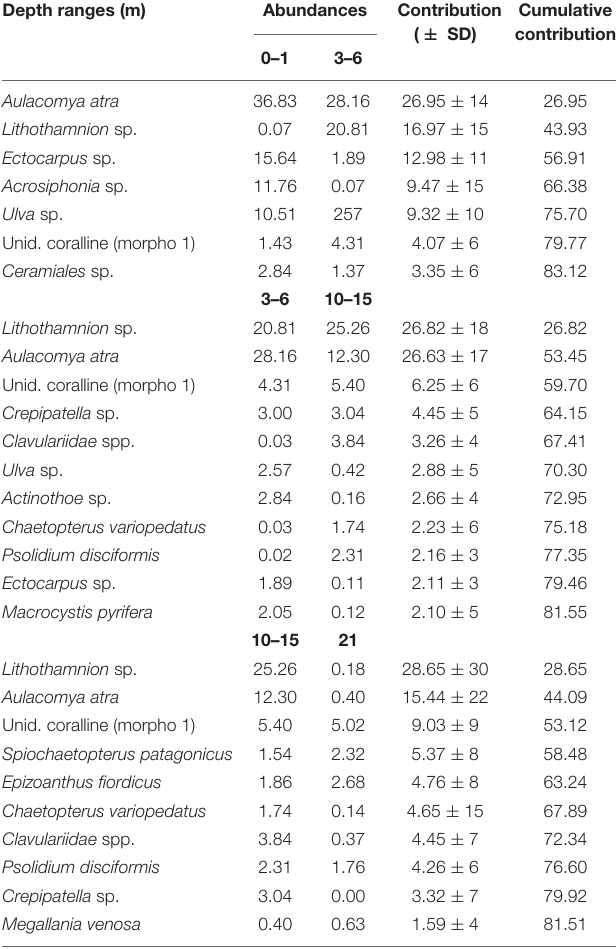
TABLE 6 | Summary of SIMPER results for depth ranges at the head of Comau fjord. Depth ranges